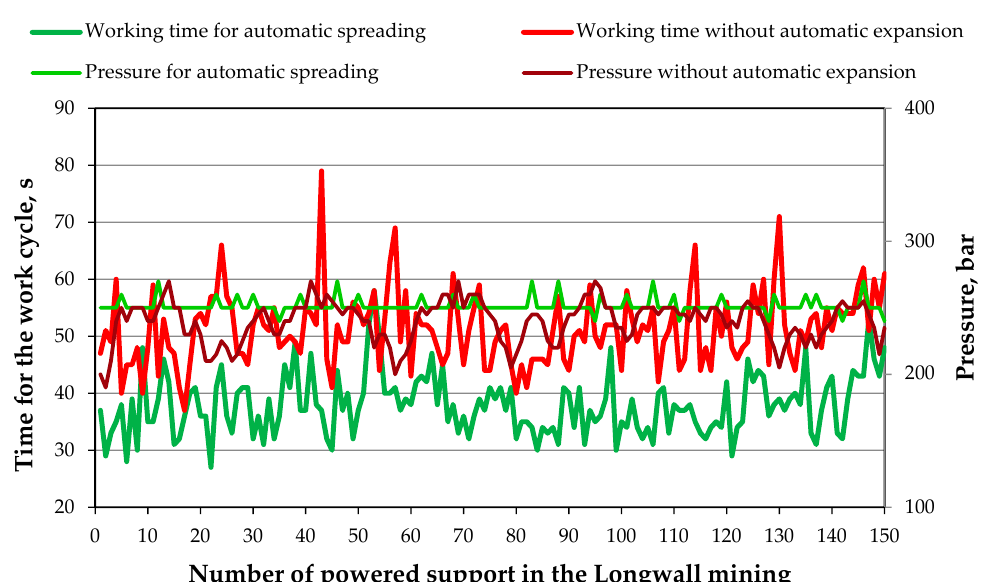
Figure 11. Compares the section operation time for a powered support equipped with an automatic leg-expansion system and for a support without the system.